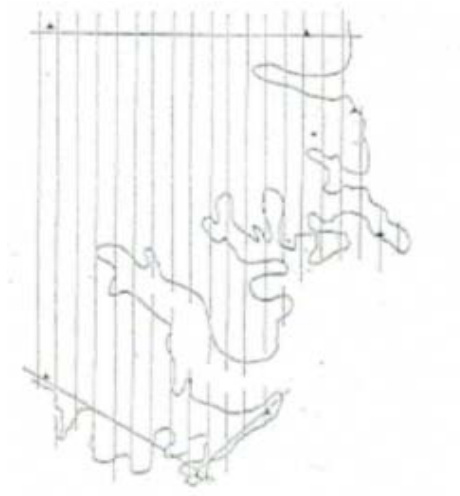
Fig.1. Baltimore County Block 1